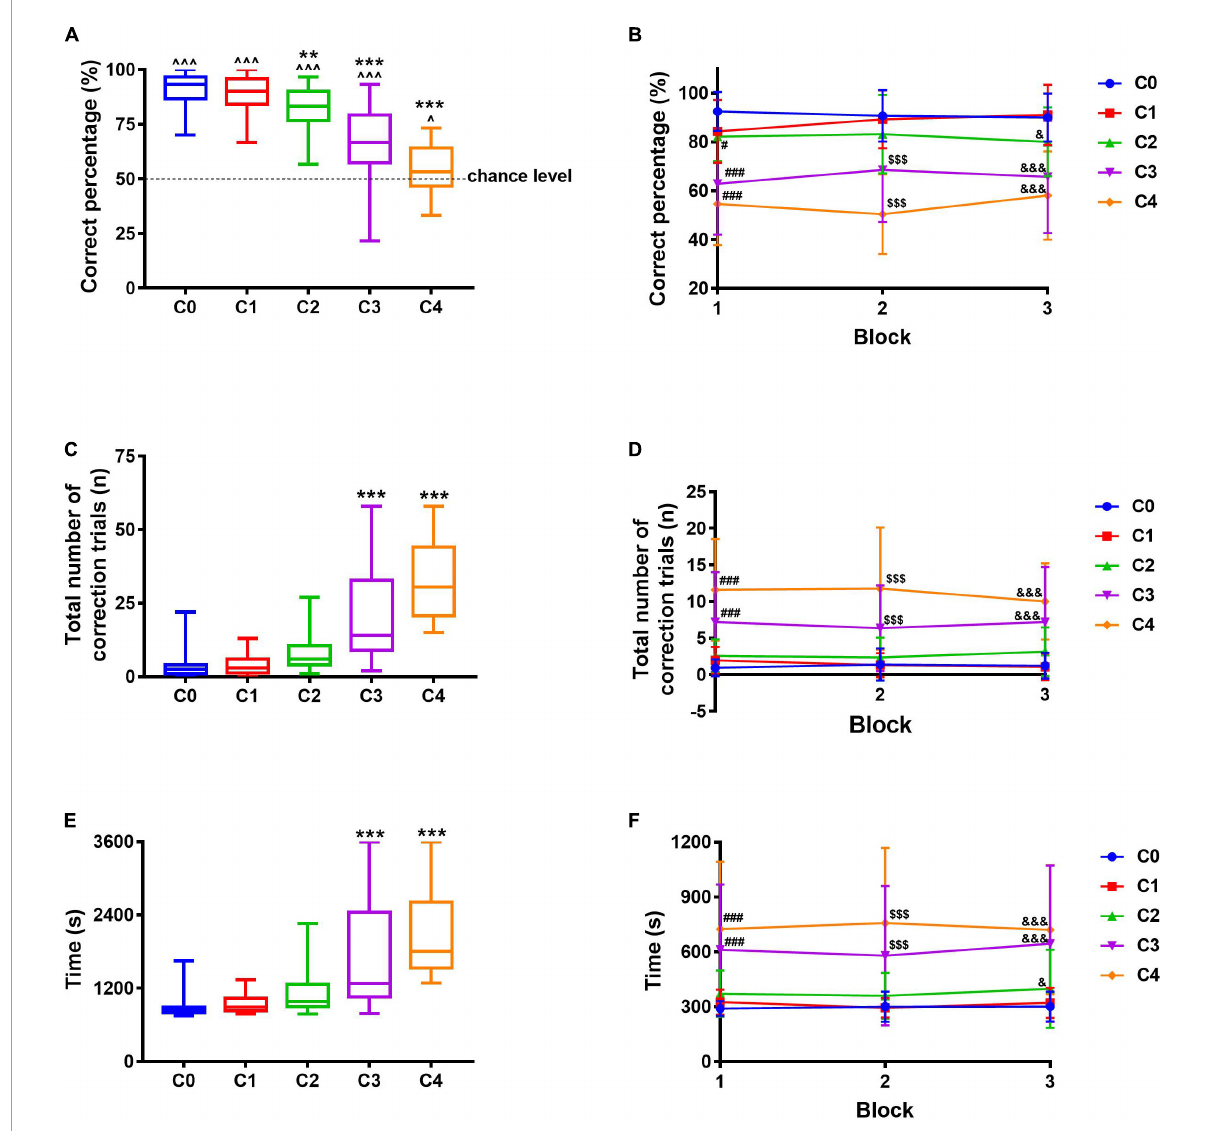
FIGURE4 Pattern completion evaluation paradigm using different images. (A) Correct percentage. (B) Correct percentage in each block. (C) The total number of correction trials. (D) The total number of correction trials in each block. (E) The total time required to complete 30 trials. (F) Time required to complete every 10 trials. Data are presented as the mean ± SD ( n = 26–28). ˆ p < 0.05 and ˆˆˆ p < 0.001 compared with chance level, one-sample t -test. ** p < 0.01 and *** p < 0.001 compared with the C0 group, one-way ANOVA followed by post hoc Dunnett’s t -test. # p < 0.05 and ### p < 0.001 compared with the C0 group during Block 1; $$$ p < 0.001 compared with the C0 group during Block 2; & p < 0.05 and &&& p < 0.001 compared with the C0 group during Block 3, two-way repeated-measures ANOVA followed by Tukey’s t